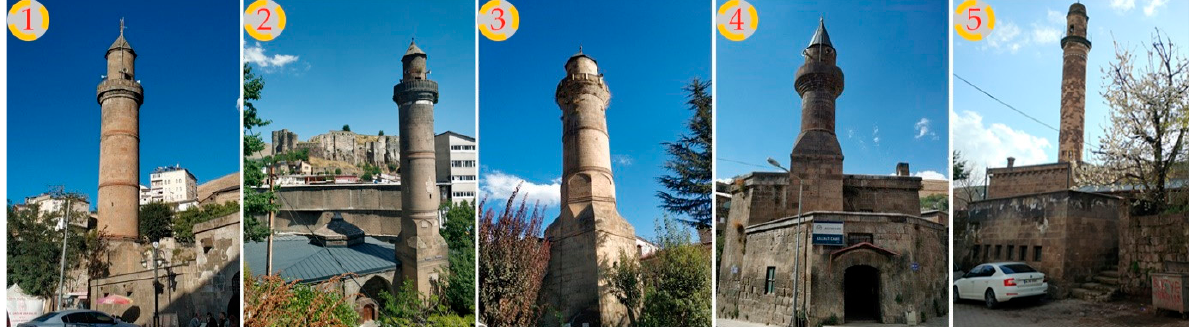
Figure 2. Visuals of Five Minarets: ( 1 ) Ulu Mosque Minaret, ( 2 ) Ş erefiye Mosque Minaret, ( 3 ) Meydan Mosque Minaret, ( 4 ) Kalealtı Mosque Minaret, and ( 5 ) Gökmeydan Mosque Minaret.